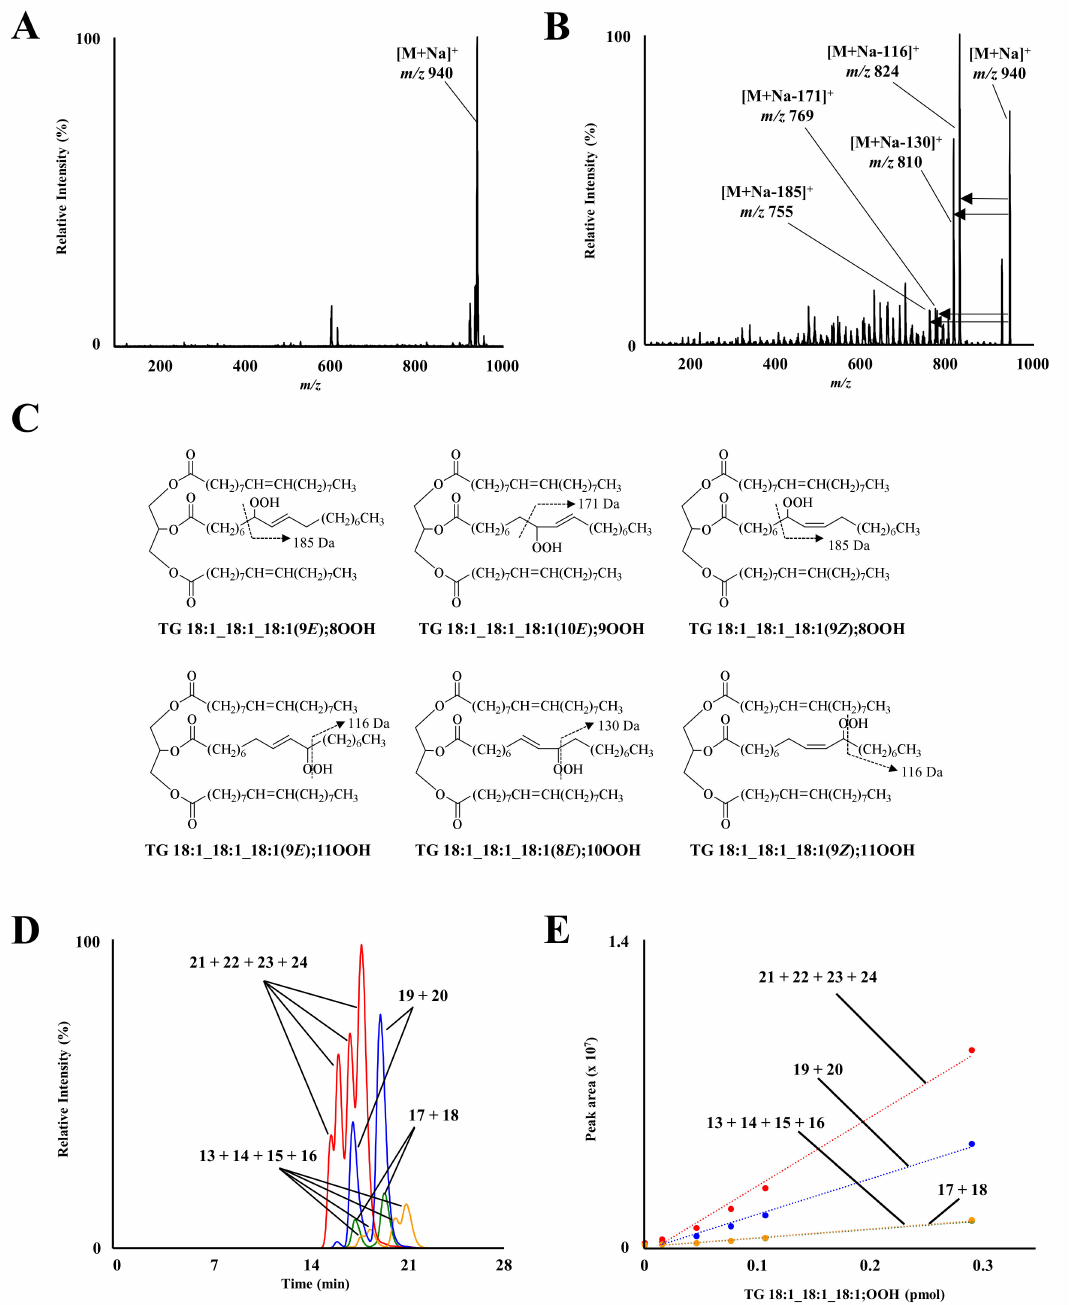
Figure 3. Q1 mass ( A ) and product ion mass ( B ) spectra of prepared TG 18:1_18:1_18:1;OOH isomers. A mixture of TG 18:1_18:1_18:1;OOH isomers (0.5 µ M in methanol) was directly infused to the MS/MS system. The ion m / z 940 [M+Na] + was used as the precursor ion. Proposed fragmentation patterns of TG 18:1_18:1_18:1;OOH isomers ( C ). LC-MS/MS chromatograms of TG 18:1_18:1_18:1;OOH isomers ( D ). A mixture of TG 18:1_18:1_18:1;OOH isomers (0.29 pmol each) were analyzed. Refer to Table 1 for peak numbers. Calibration curves of reference TG 18:1_18:1_18:1;OOH isomers ( E